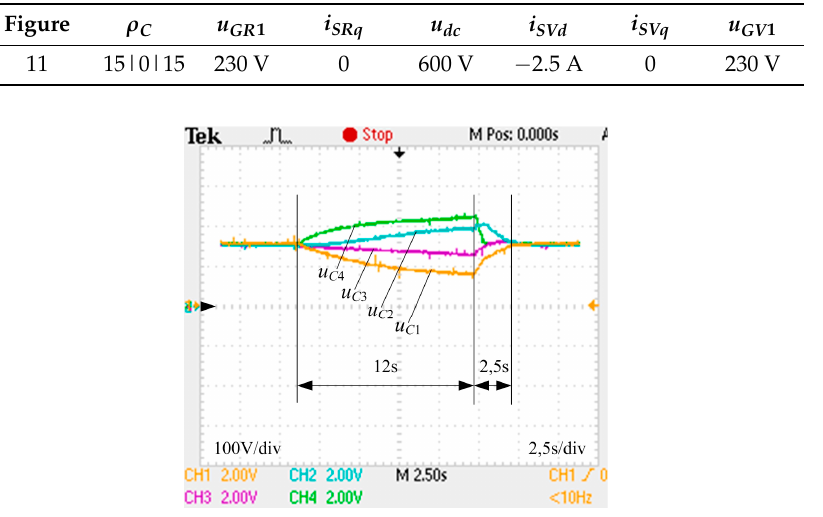
Figure 11. Capacitor voltage balancing experimental result, CH1: u C 1 ; CH2: u C 2 ; CH3: u C 3 ; CH4: u C 4 ; 100 V/div; 2.5 s/div.